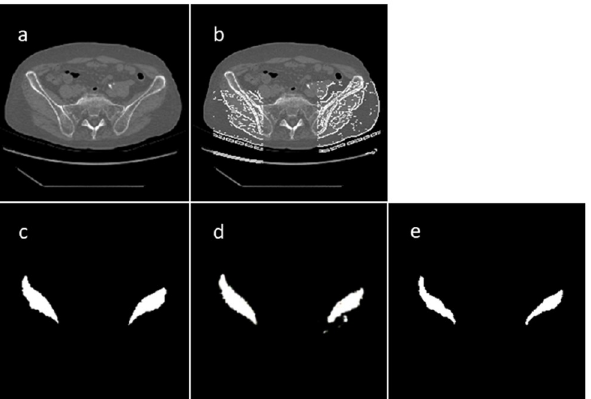
Fig 2. CT and segmentation images: (a) original CT image, (b) guide image using Canny edge detector, (c) manual segmentation image of GMd contours, (d) Auto-segmentation image obtained using learning model with beta1 = 0.9, L1_weight = 1000, and 100 epochs, and (e) manually segmented image prepared by another operator.